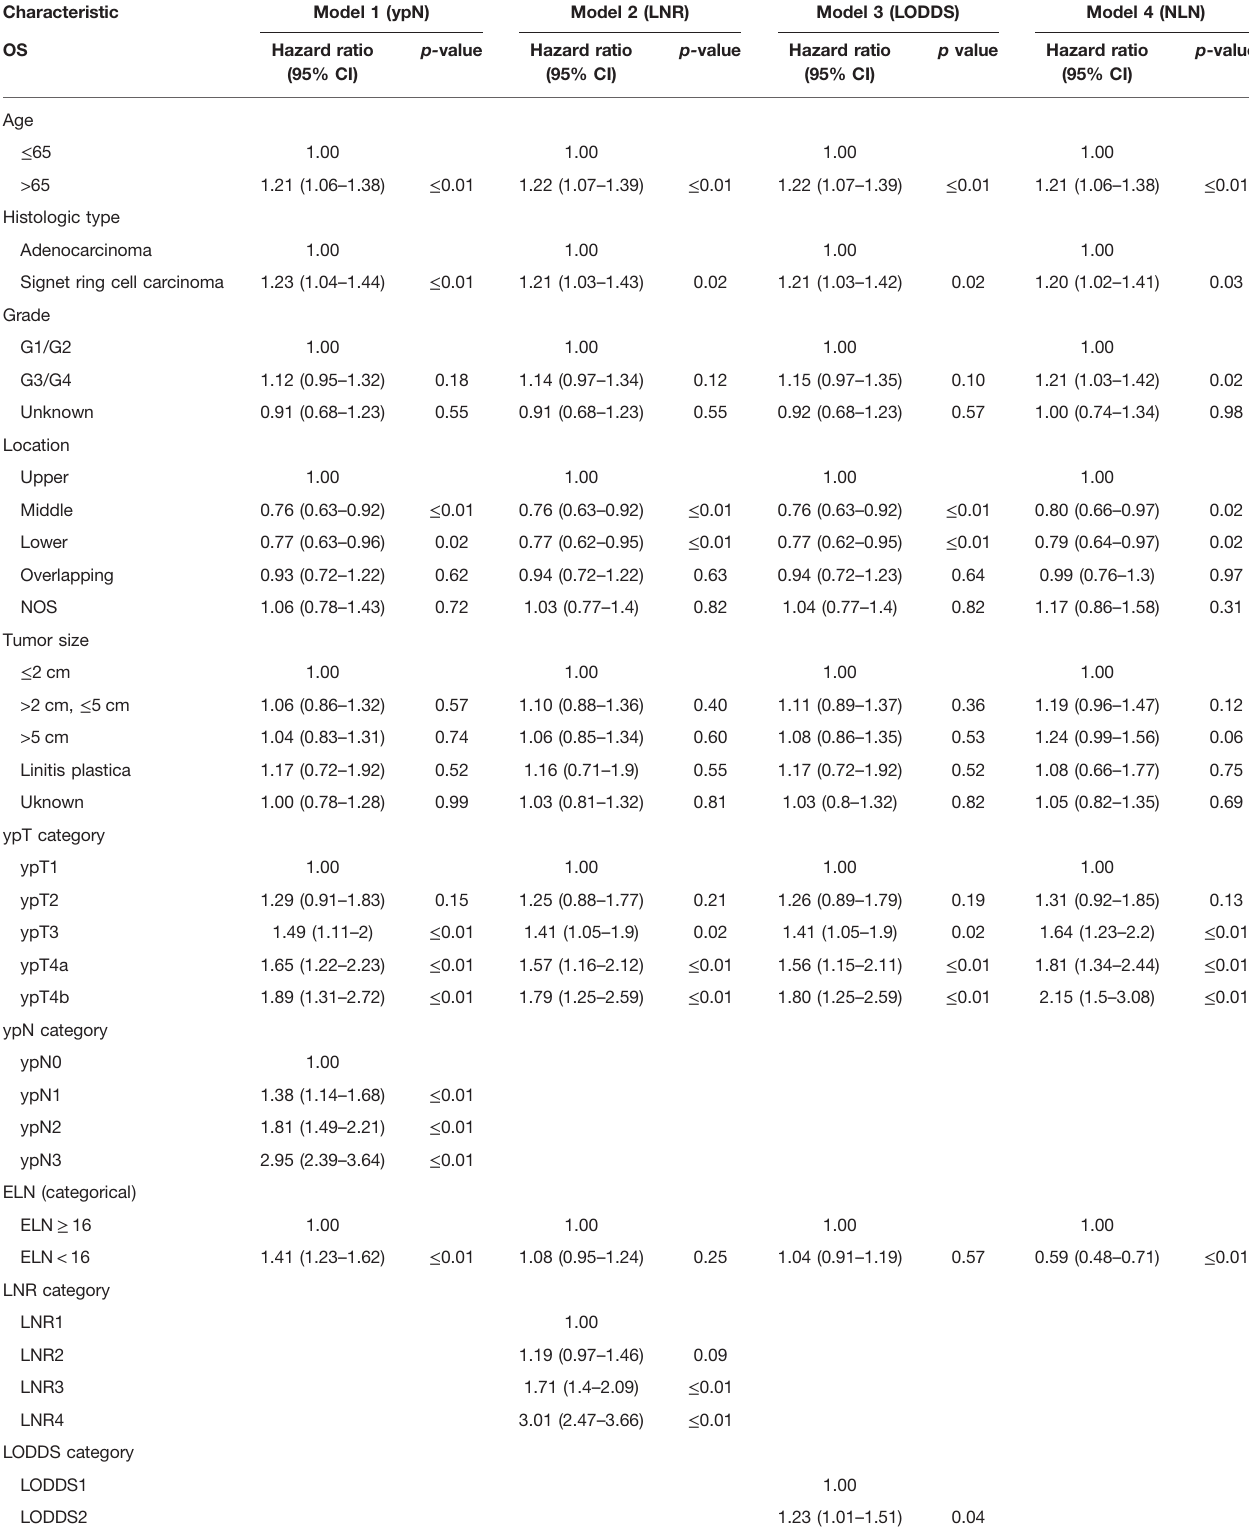
TABLE 2 | Multivariate Cox regression analysis of prognostic predictors for OS in gastric adenocarcinoma patients after